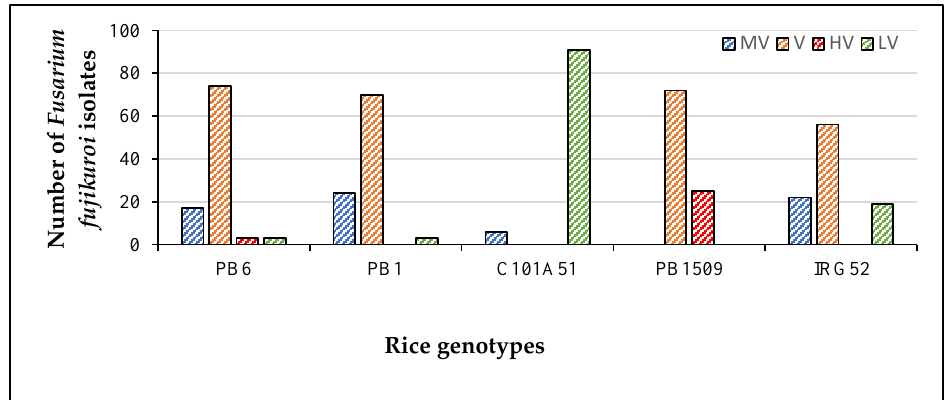
Figure 5. Virulence pattern of Fusarium fujikuroi isolates in rice genotypes differing in their resistance. Isolates were classified into moderately virulent (MV), virulent (V), highly virulent (HV), and less virulent (LV) based on degree of pathogenicity. The two-way ANOVA test indicated significant differences between isolates (Sup- plementary Table S5 ). Therefore, we compared the isolates using Tukey’s HSD test. Among the 97 isolates, F213 had a significant positive effect on the disease incidence, fol- lowed by F239 (Supplementary Table S6). The isolates F220 and F226 can be classified as one group and F233 as another group. Further, the isolates F287, F297, F214, F344, and F255a had no significant positive effect on the disease as compared to other isolates. All other remaining isolates can be classified as one group with a significant positive effect in the development of bakanae disease. 2.4. Pathotype Classification of Fusarium fujikuroi Isolates A total of 15 pathotype groups were identified based on the responses of the rice genotypes to the Fusarium fujikuroi isolates (Table 3). The pathotype group 1 consists of 19 isolates that showed susceptible reactions in all rice genotypes except C101A51, followed by pathotype 2 and pathotype 3, which include 13 and 9 isolates, respectively. The patho- type group 1 is more prevalent as compared to other groups. The pathotype group 12 showed the maximum variability in virulence pattern, with HS, S, HR, HS, and S reactions in PB6, PB1, C101A51, PB1509, and IRG52, respectively. The pathotype group 4 showed an S reaction in PB6, PB1, and IRG52, while a HS reaction was observed in PB1509 and HR in C101A51. The responses of rice genotypes to some representative Fusarium fujikuroi isolates and their corresponding pathotype groups are given in Figure 2. The isolates in pathotype group 8 showed a susceptible reaction in all rice genotypes except C101A51. This group can be classified as a highly virulent one and consists of six isolates, F213, F244, F250, F274, F277, and F343 (Table 3). Further, the isolate F213 was separated from other isolates due to its virulence (Supplementary Table S6). It is also interesting to observe the pattern of virulence in pathotypes 13 and 15, which produced a resistance reaction in all genotypes (in general) except PB1509, having a susceptibility reaction (Table 3). Table 3. Pathotype classification of Fusarium fujikuroi isolates based on pattern of disease reaction in rice genotypes differing in their resistance. Pathotypes